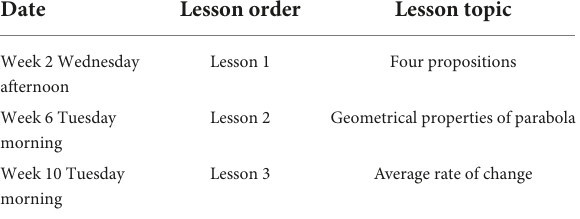
TABLE 1 The schedule and the content of the lessons.